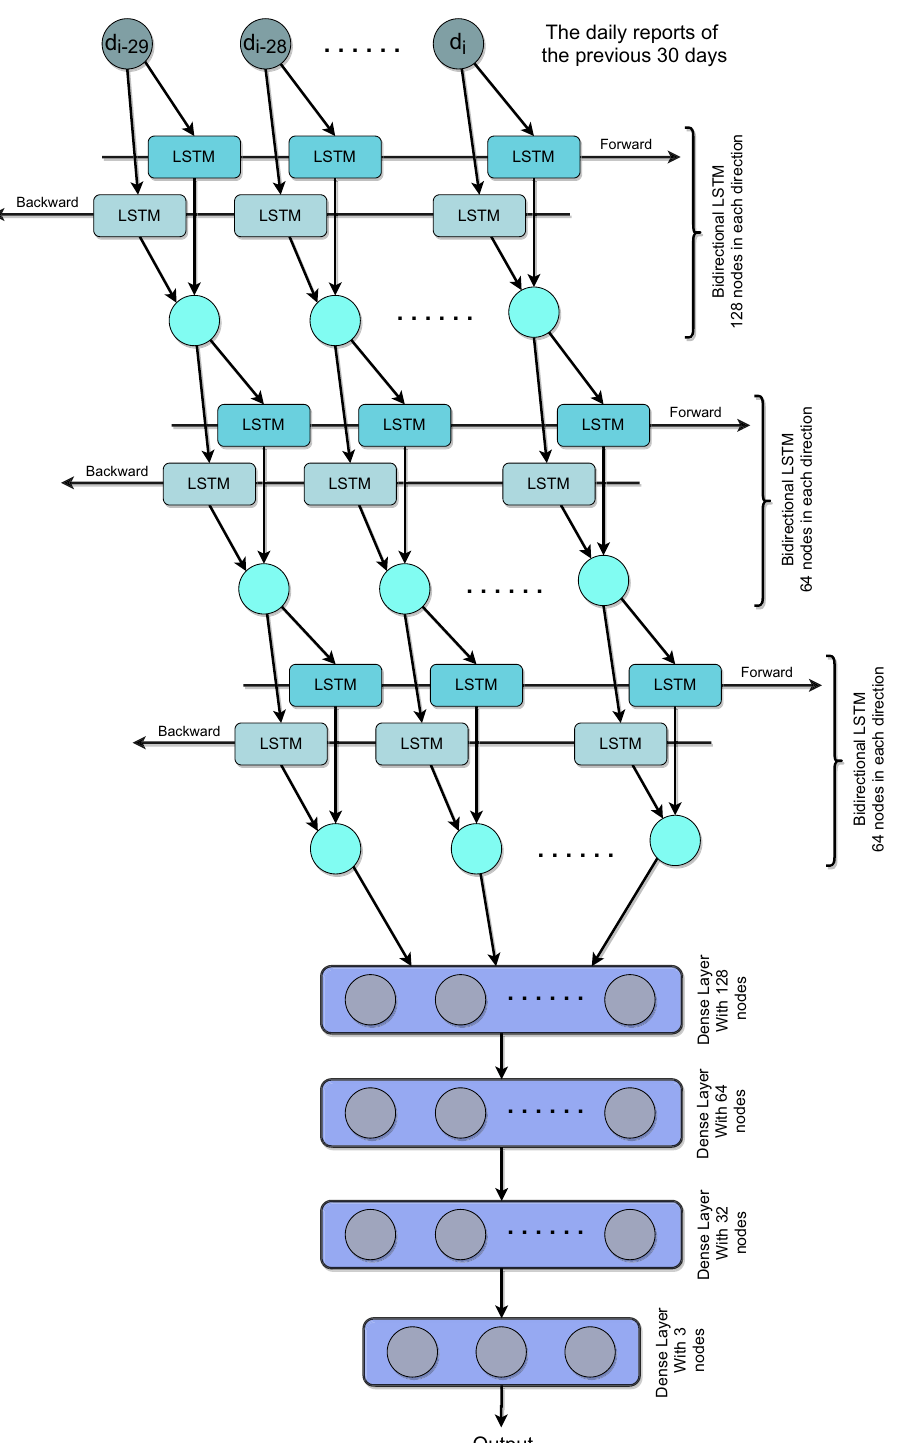
Figure 6. The figure describes the memory-based agent neural network architecture of the agent. The agent uses three bidirectional LSTM layers with 128, 64, and 64 nodes, respectively. It is further followed by four dense layers of 128, 64, 32, and 3